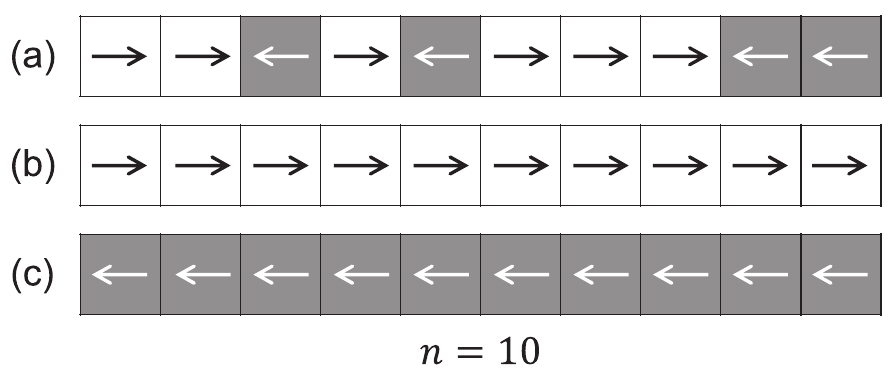
Fig 13. Theoretical grid for estimating the effect of counter flow. Examples of row configurations with n = 10 cells, gray cell indicates counter flow. In case (a) it is not possible to pass from one side to the other in neither direction. Case (b) and (c) represent “open” cases in the right and left direction respectively. Please note that letters used here do not refer to the 3 experimental groups considered earlier.